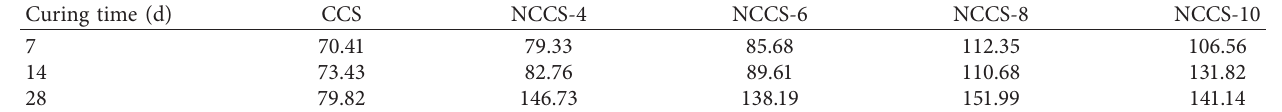
Table 6: The calculation result of the deformation modulus of NCCS (MPa).